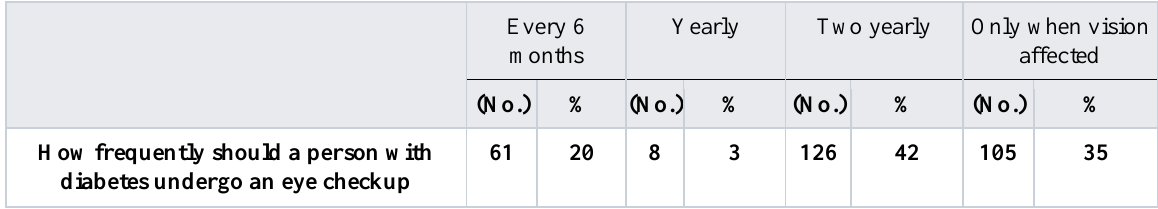
How frequently should a person with diabetes undergo an eye checkup